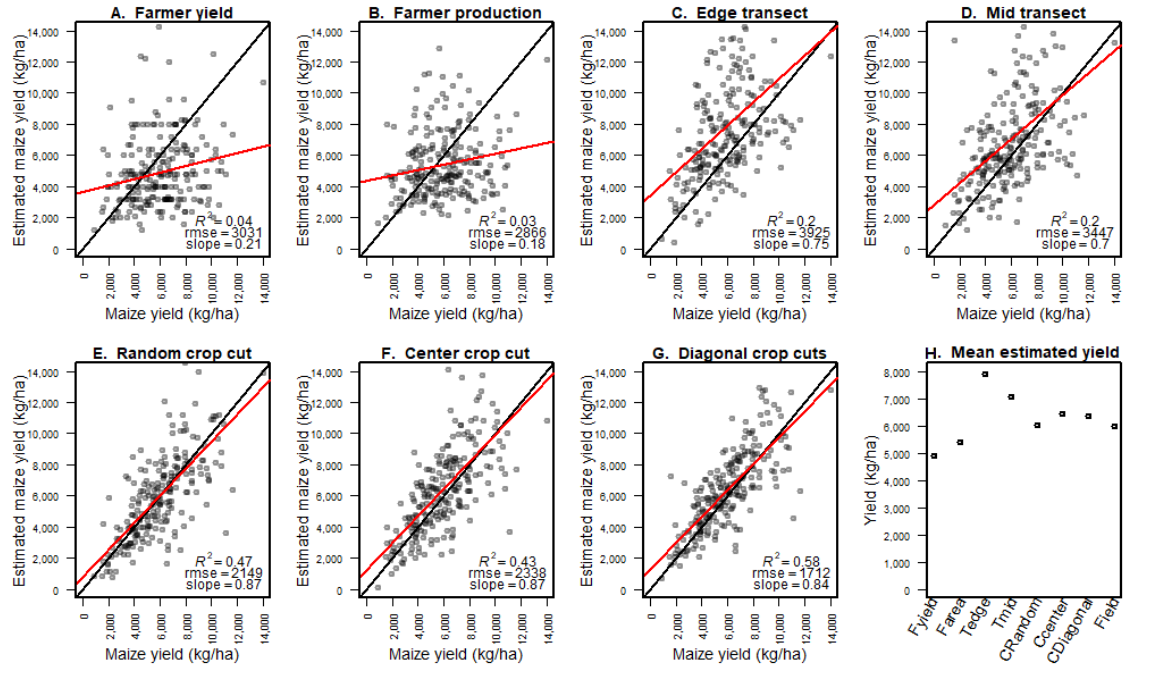
Figure 1. Maize yield (kg/ha) estimates from seven field sampling methods versus the true maize yield that was measured by harvesting the entire field. The black lines are the identity (y = x), and the red line is a linear regression model, with the associated adjusted R 2 displayed on each plot. The final panel shows the mean yield estimate by the sampling method; see Table 1.